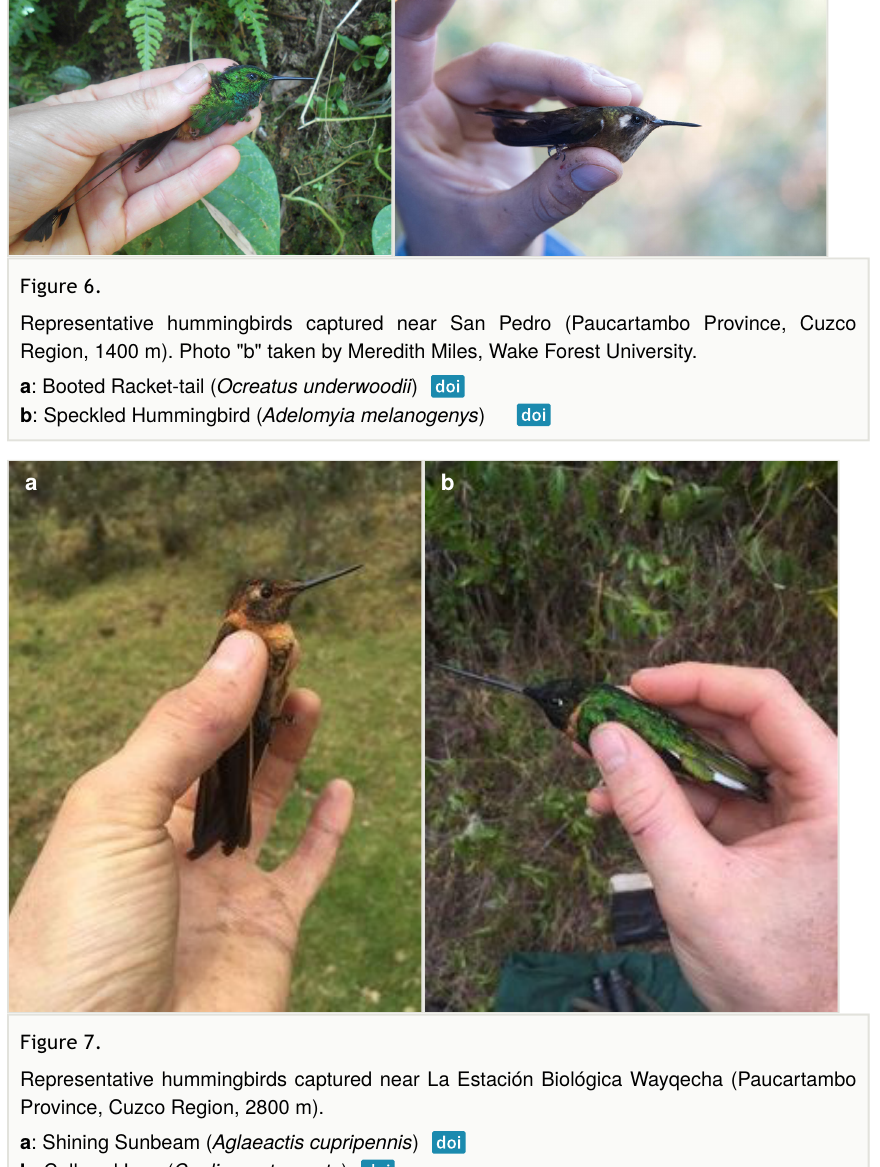
Representative hummingbirds captured near La Estación Biológica Wayqecha (Paucartambo Province, Cuzco Region, 2800